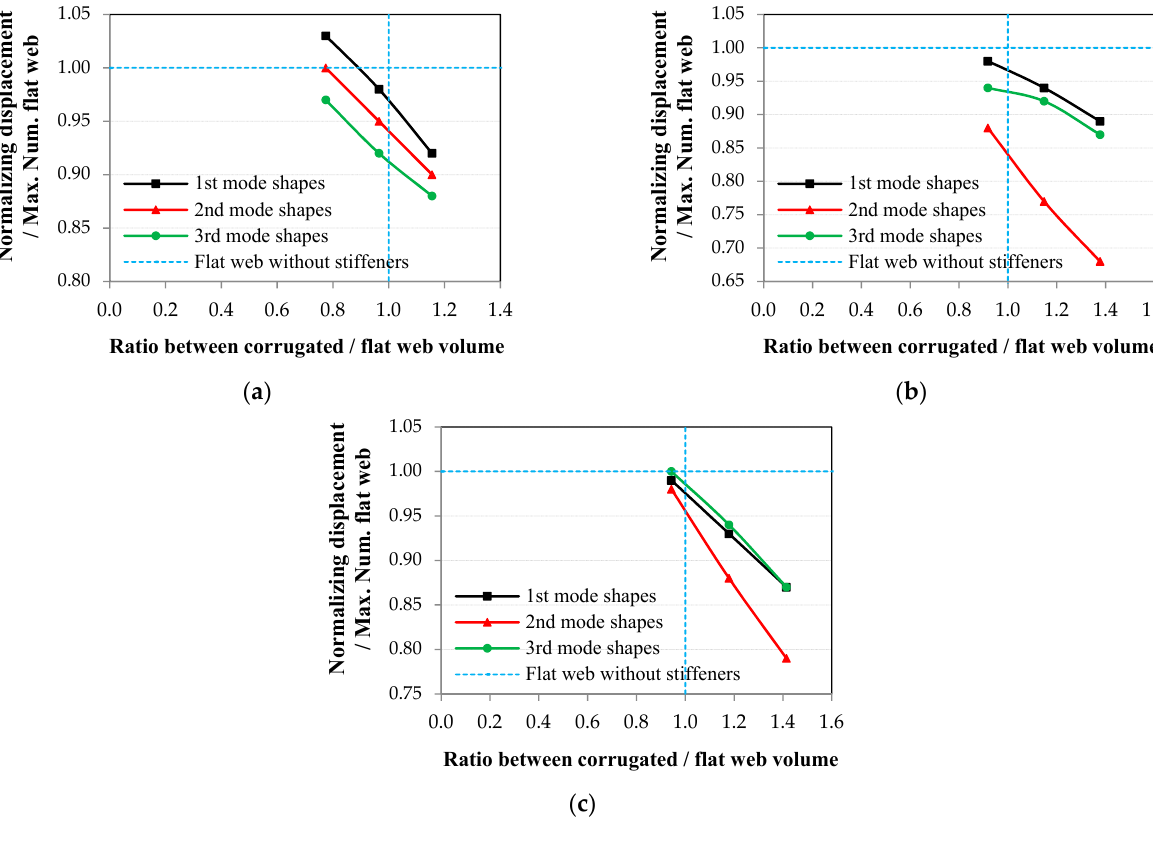
Figure 21. The relationship between normalized displacement and the ratio between corrugated to flat web volume for the 1st, 2nd, and 3rd mode shapes: ( a ) trapezoidal web, ( b ) rectangular web, and ( c ) triangular web.